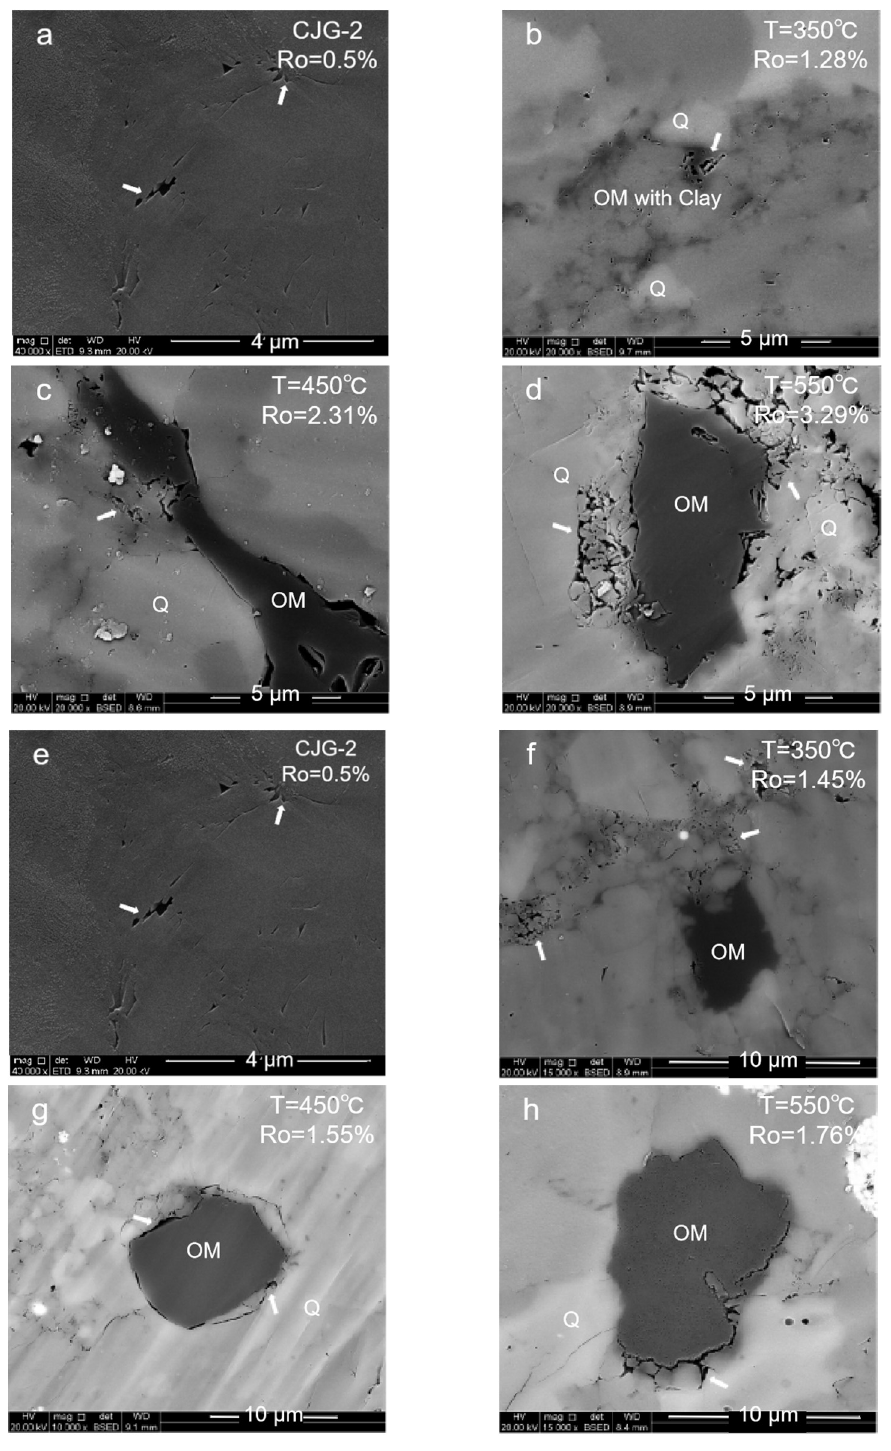
Figure 6. Evolution of the brittle mineral pores in two groups under different temperatures. ( a ) Original sample, many primary brittle mineral pores in the original sample. ( b ) Group 1, semiclosed system, T = 350 °C, little dissolution pores around the organic matter. ( c ) Group 1, semiclosed system, T = 450 °C, dissolution pores around the organic matter. ( d ) Group 1, semiclosed system, T = 550 °C, dissolution pores were enlarged. ( e ) Original sample, many primary brittle mineral pores in the original sample. ( f ) Group 2, open system, T = 350 °C, dissolution pores with clay mineral. ( g ) Group 2, open system, T = 450 °C, dissolution pores around the organic matter. ( h ) Group 2, open system, T = 550 °C, dissolution pores were enlarged.